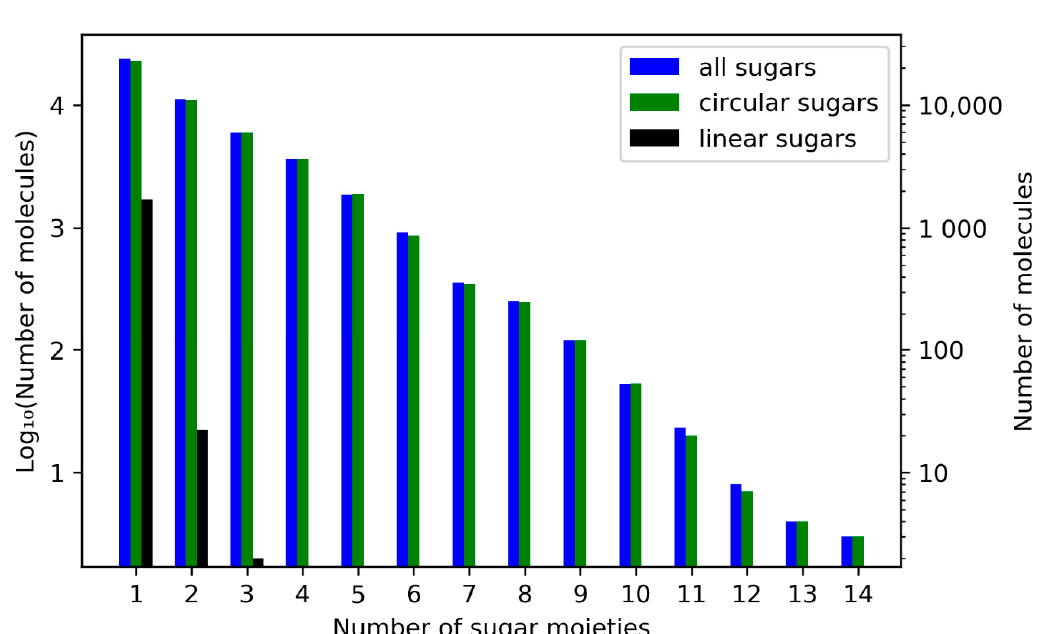
Figure 7. Frequencies for the total number of sugar moieties in a single molecule out of all molecules in COCONUT with glycosidic moieties. Numbers of molecules with the respective total number of sugar moieties are in a logarithmic scale on both ordinates. On the left vertical axis, units of the base-10 logarithm are plotted, and the untransformed numbers are given on the right. The blue bars disregard the types of sugars, whereas the other bars give the respective numbers only for circular (green) or linear (black) sugar moieties.